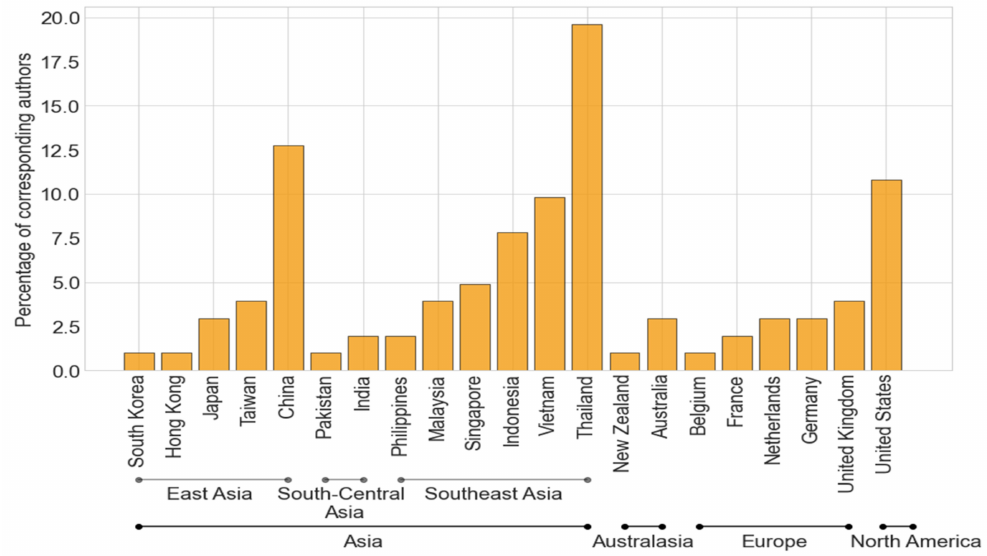
Figure 6. The contribution of corresponding authors to drought publications over the past two decades. Among the Southeast Asian countries, Thailand and Vietnam had the highest percentage of corresponding authors, whereas China and the United States of America contributed significantly to the remote sensing-based drought studies of Southeast